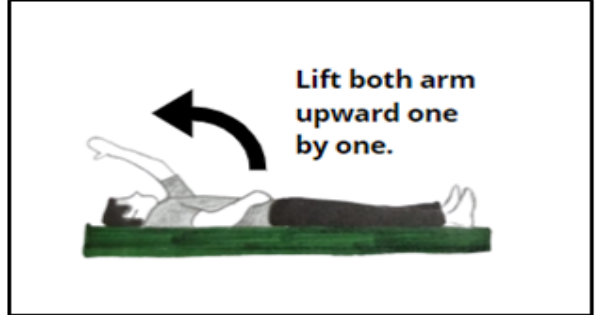
Figure-VI: Demonstration of lifting arms while lying in